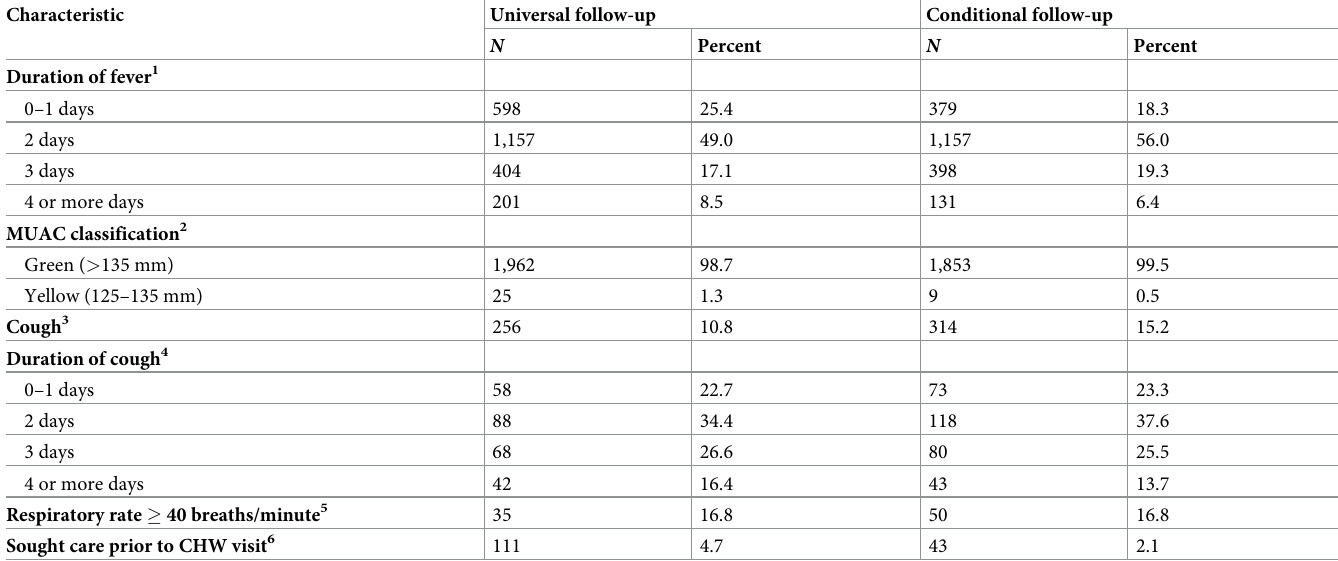
Table 2. Clinical and care-seeking descriptors of enrolled children at initial presentation to